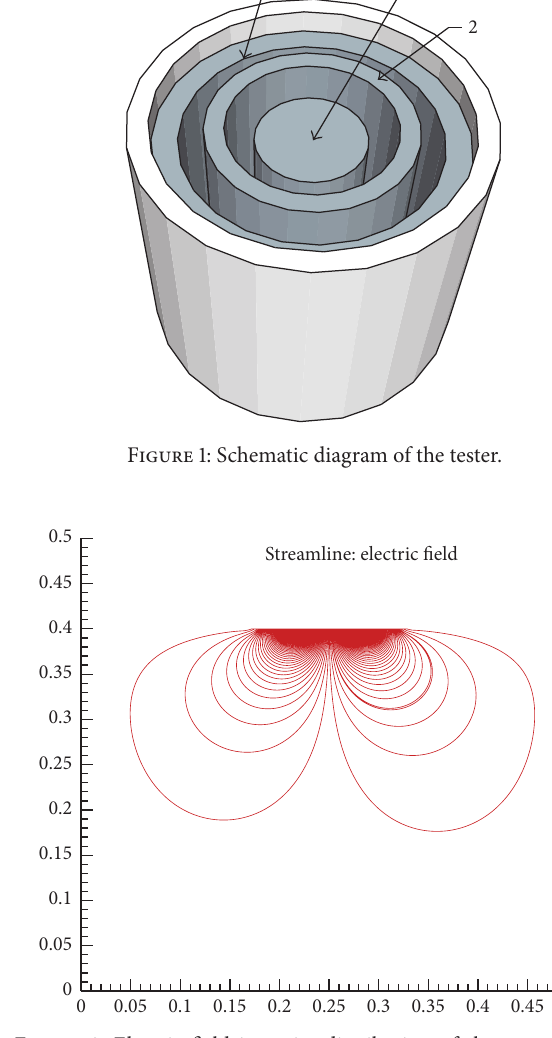
Figure 2: Electric field intensity distribution of the near-surface